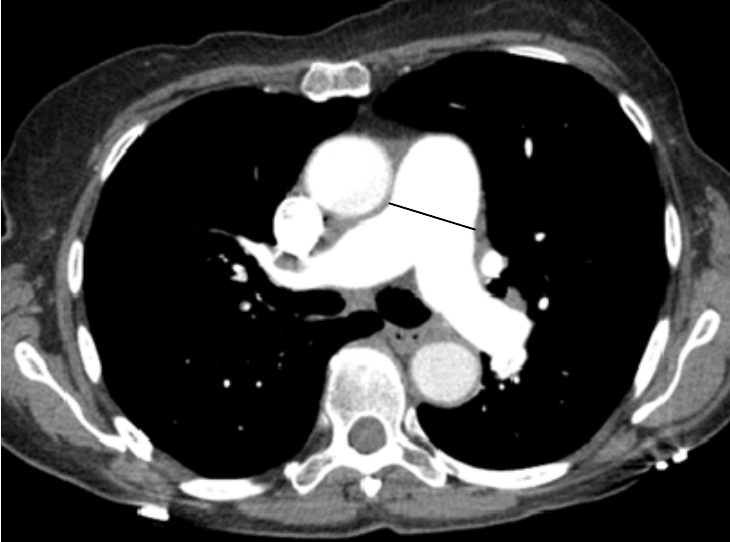
Figure 1. Measurements of main pulmonary artery and ascending aorta at the level of bifurcation. The main pulmonary artery (PA) size is typically taken at the level of the bifurcation of the main pulmonary artery perpendicular to the vessel wall. The aortic dimension of the ascending aorta is taken at the same level to calculate the PA to the aortic diameter (PA/Ao) ratio. The diameter is determined using the internal diameter in the contrast-enhanced